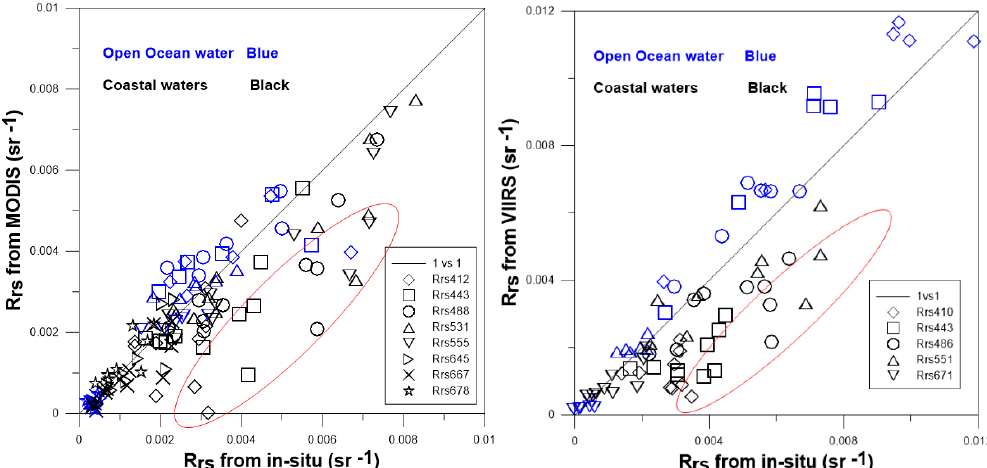
Figure 7. Scatterplot of the satellite-derived versus in situ remote-sensing reflectance in the SCS (left: MODIS-AQUA, total R 2 = 0.76; right: VIIRS, total R 2 = 0.80). The color code and the outliers are similar as in Figure 6. The red circles correspond to the outliers for the BoS region.